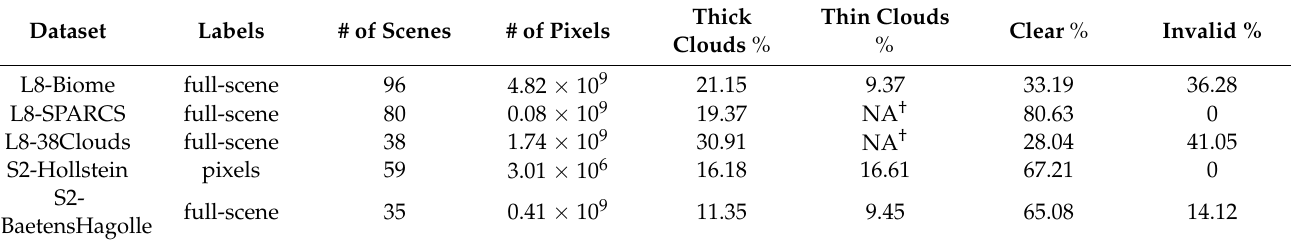
Figure 1. Location of the Landsat-8 and Sentinel-2 images in each dataset. Each image includes a manually generated cloud mask to be used as the ground truth. SPARCS, Spatial Procedures for Automated Removal of Cloud and Shadow. Table 1. Ground truth statistics of each of the Landsat-8 and Sentinel-2